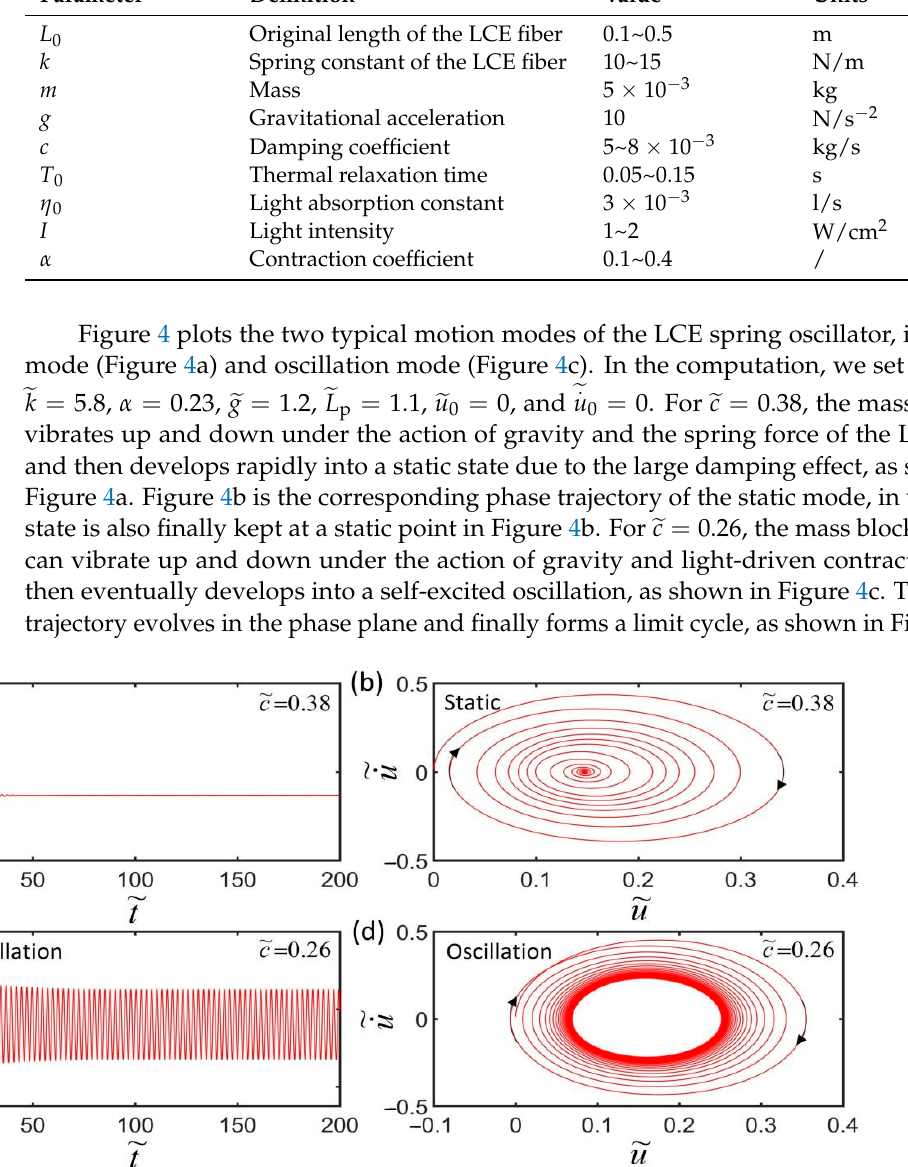
Figure 4. Two motion modes of the LCE spring oscillator: ( a , b ) Static state ( (cid:101) c = 0.38); ( c , d ) oscillation state ( (cid:101) c = 0.26). The other dimensionless parameters are: (cid:101) I = 0.35, (cid:101) k = 5.8, α = 0.23, (cid:101) g = 1.2, (cid:101) L p = 1.1, (cid:101) u 0 = 0, and (cid:101)